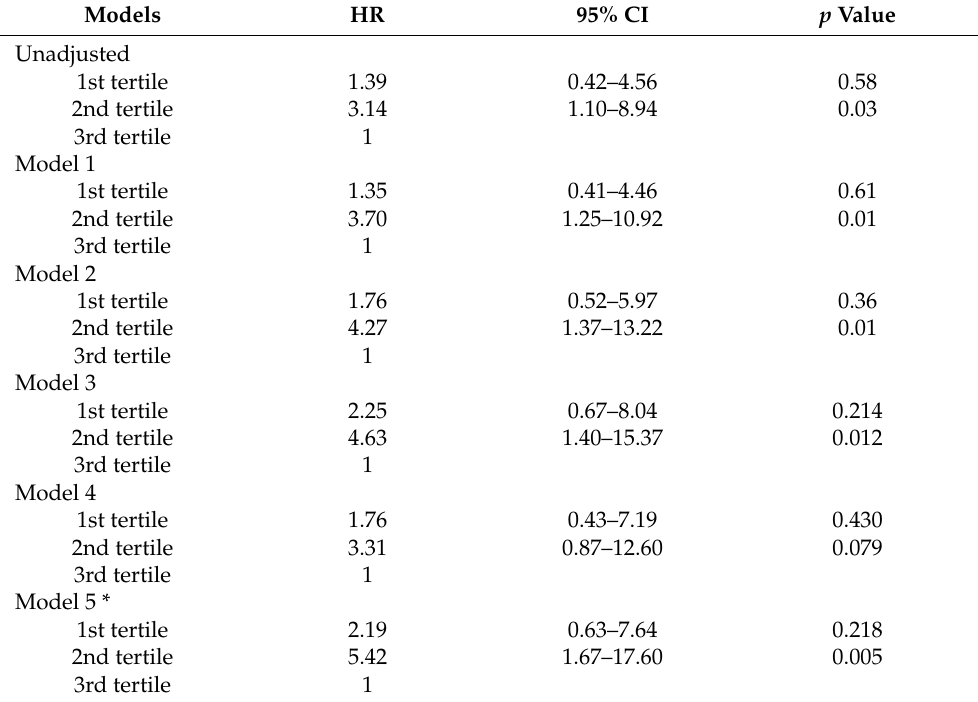
Figure 3. Kaplan–Meyer analysis of the associations of serum levels of ( A ) indoxyl sulfate and ( B ) P-cresyl sylfate with cardiovascular events. Table 3. Stepwise multivariate Cox regression analysis of risk factors at baseline for experiencing a cardiovascular event: indoxyl sulfate concentrations shown as tertiles.